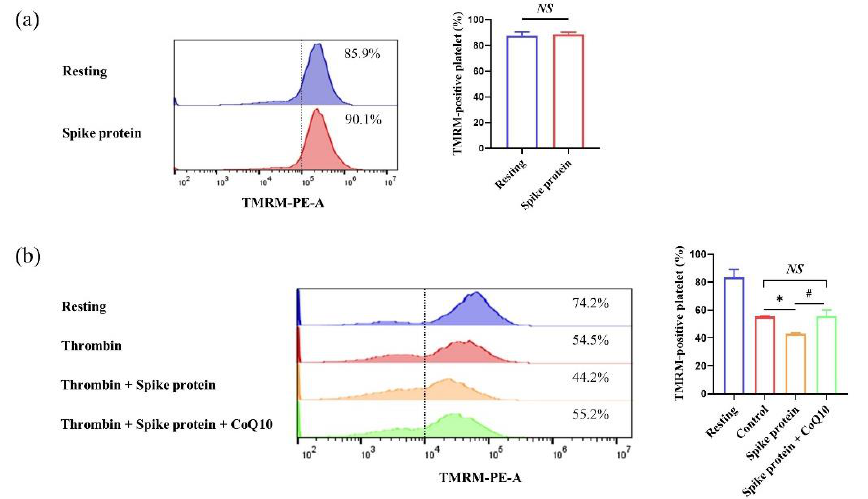
Figure 5. CoQ10 inhibits spike protein-potentiated platelet mitochondrial membrane potential dissipation. ( a ) Platelets were incubated with 2 μg /mL spike protein for 10 min, then incubated with 400 nM TMRM for 20 min ( n = 3). ( b ) Platelets were incubated with 100 μM CoQ10 or solvent for 50 min in the dark, then incubated with 2 µ g/mL spike protein for 10 min, followed by stimulation with 1 U/mL thrombin for 30 min, then incubated with 400 nM TMRM for 20 min ( n = 3). TMRM- positive platelet was measured by flow cytometry. All data are presented as mean ± SEM. * p < 0.05 indicates a significant difference compared to the control group. # p < 0.05 indicates a significant difference between two groups. NS , no significant difference between two groups.